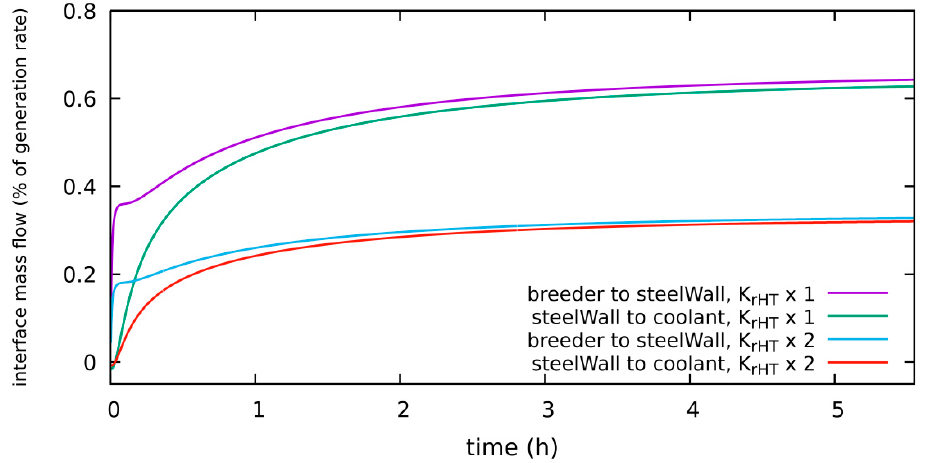
Figure 12. Transient tritium flow through patch interfaces breeder to and from steel, and steel to and from coolant for K = 1 vs. K = 2.